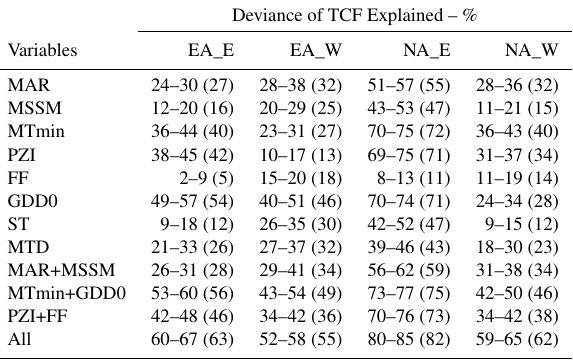
Table 2. Summary of GAMs performed using random samples of 1000 grid cells each. The ranges represent the spread of results obtained with different samples, whereas the values in parenthe- sis correspond to the average from the samples. Statistical p values are < 0 . 0001 for every case. Percentages of explained deviance are a measure of the goodness of fit of each GAM (McCullagh and Nelder, 1989; Agresti, 1996). Reported values are related to the influence on tree-cover fraction distribution of mean annual rain- fall (MAR), mean minimum temperature (MTmin), growing de- gree days above 0 ◦ C (GDD0), permafrost distribution (PZI), mean spring soil moisture (MSSM), wildfire occurrence frequency (FF), soil texture (ST), mean thawing depth (MTD). Values are divided within the four regions of interest, namely, eastern North Eurasia (EA_E), western North Eurasia (EA_W), eastern North America (NA_E), and western North America